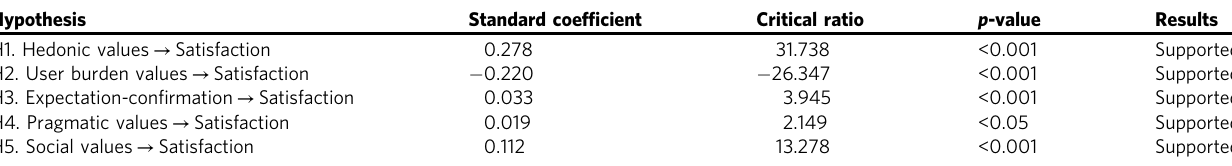
Table 3 Summary of the results for gami fi ed fi tness applications.